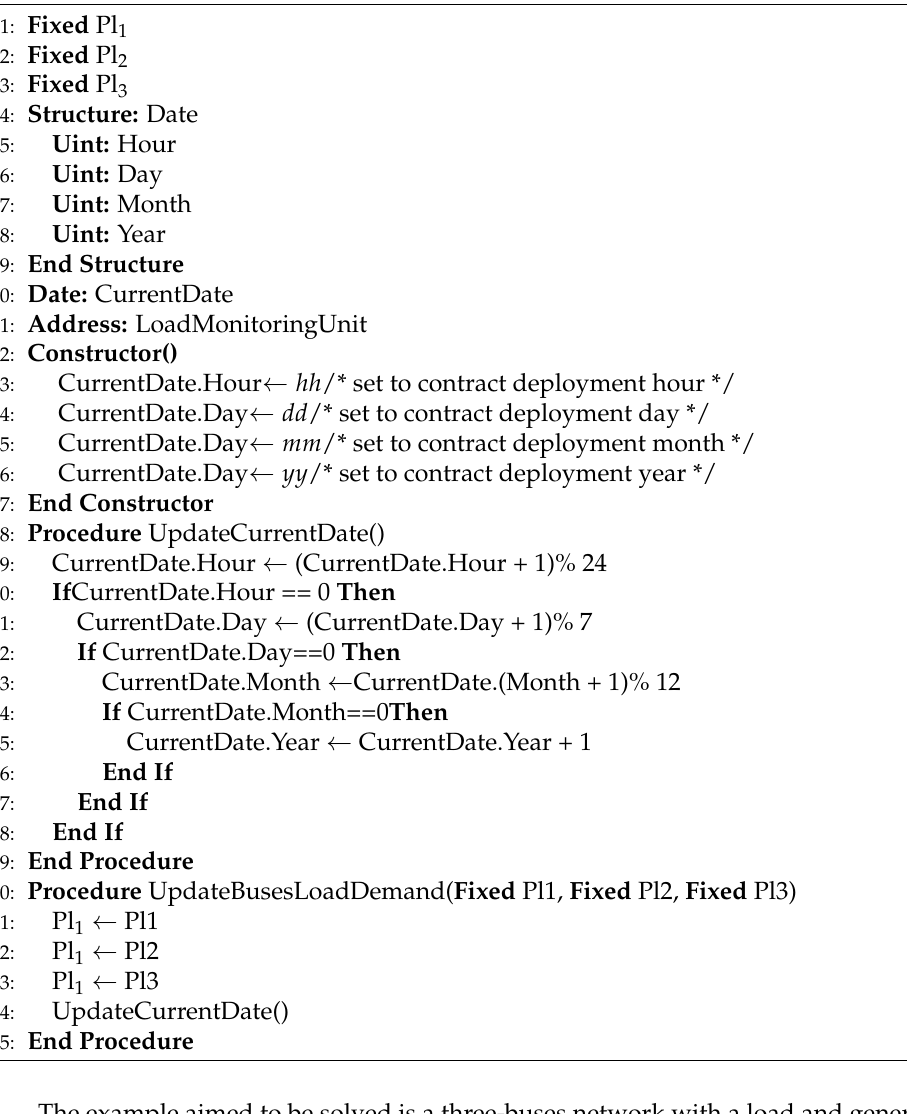
Algorithm 1 OPF Solver Smart contract: Update DC-OPF Buses Load Demand